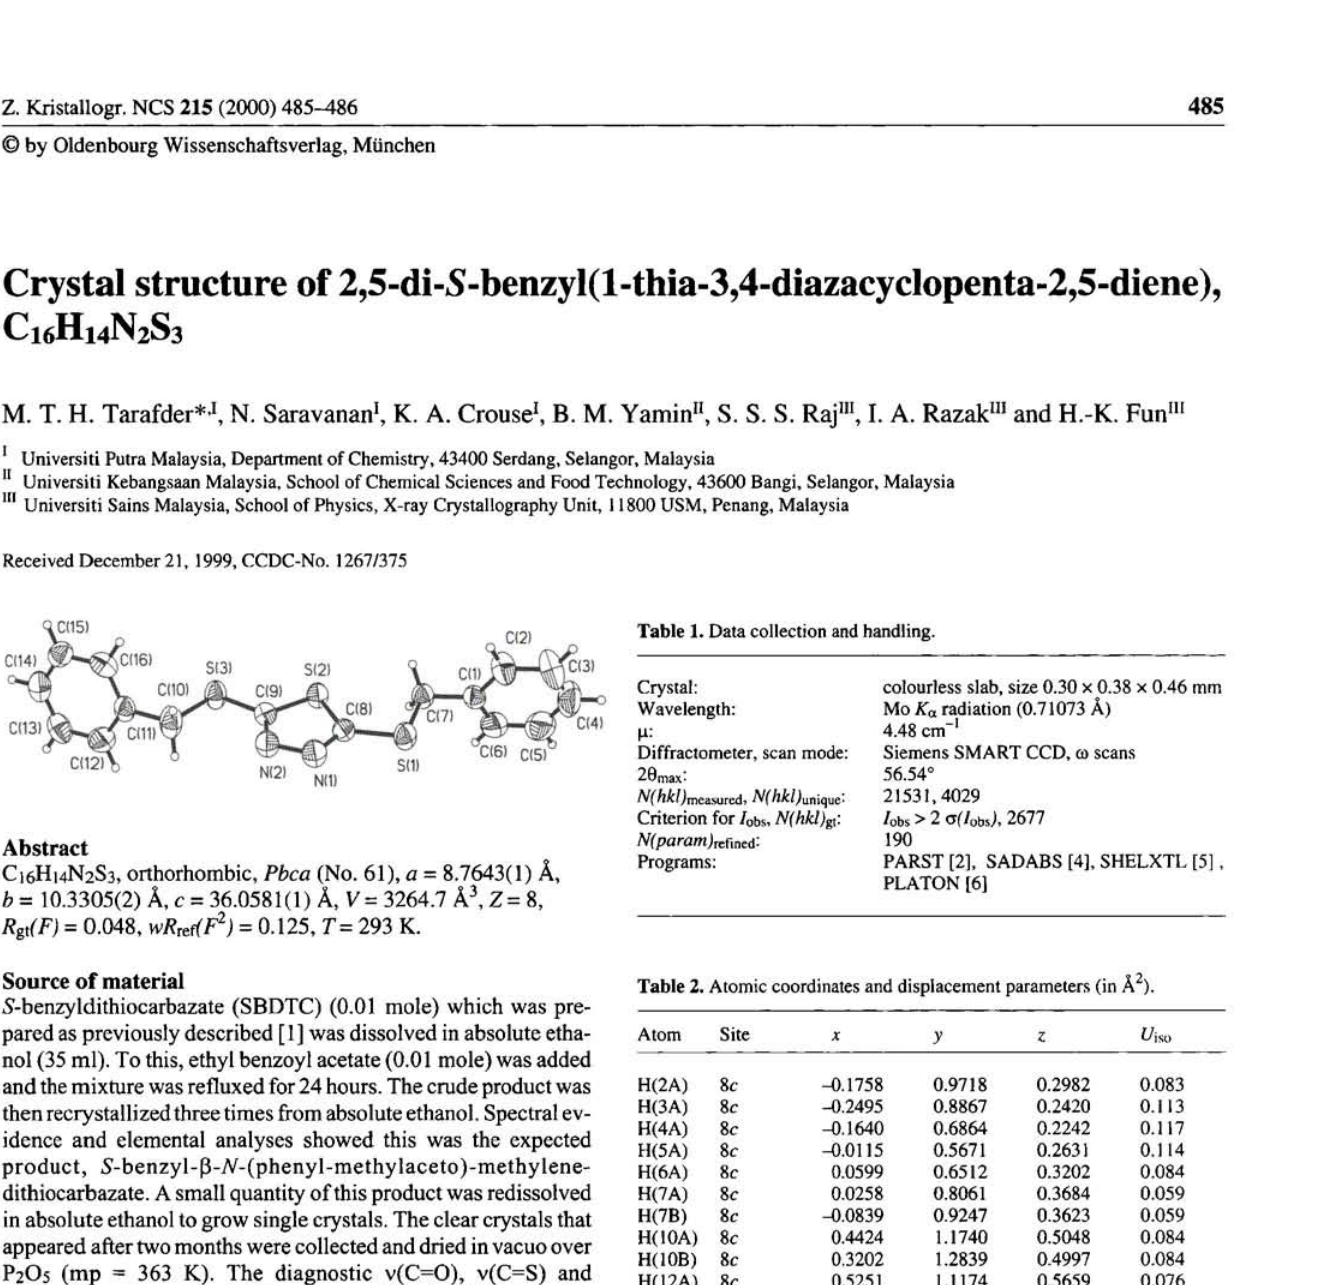
Table 3. Atomic coordinates and displacement parameters (in A 2 ).